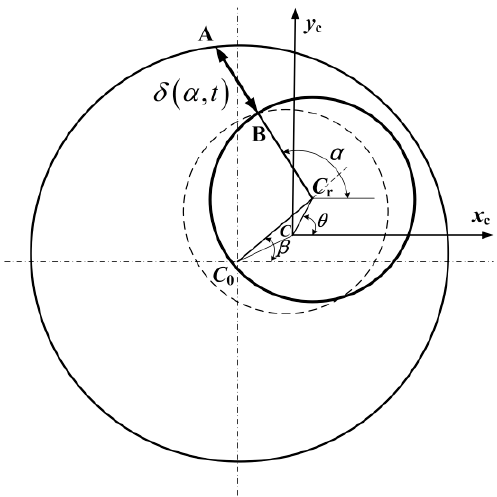
Figure 1. Air-gap for a cross section in a permanent magnet synchronous motor (PMSM).